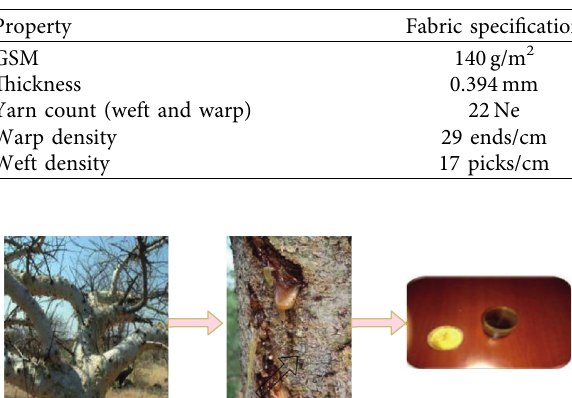
Table 1: Cotton fabric sample specifications.